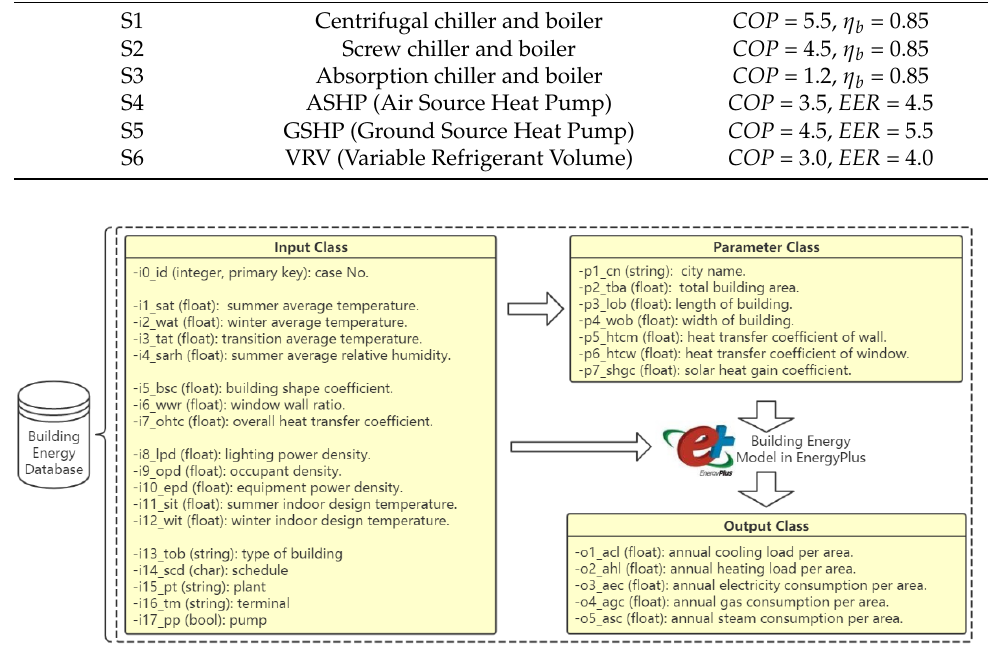
Figure A2. Storage form of the pre-simulated database.